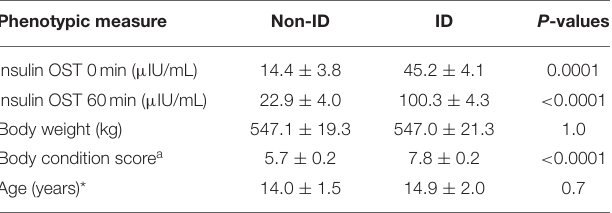
TABLE 1 | Insulin concentrations before and 60min post oral sugar test, initial body weight and body condition score, and age for the non-ID and ID horses. Phenotypic measure